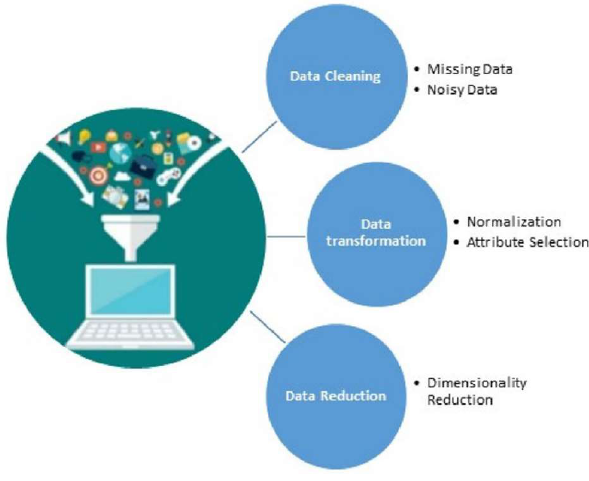
Figure 6. Steps of